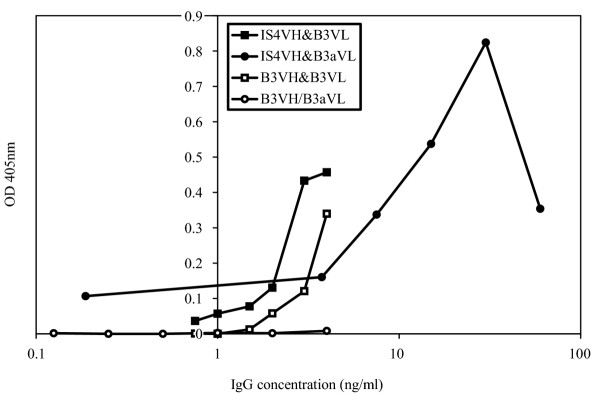
Effect of point mutation Arg27a to serine in B3 variable light chainregion (VL) complementarity determining region 1. Comparison of cardiolipin binding of IgG in COS-7 cell supernatants containing wild-type heavy chains expressed with B3VL or B3VLa. Presented as concentration of IgG in the supernatant versus optical density (OD) at 405 nm in the anti-cardiolipin ELISA.